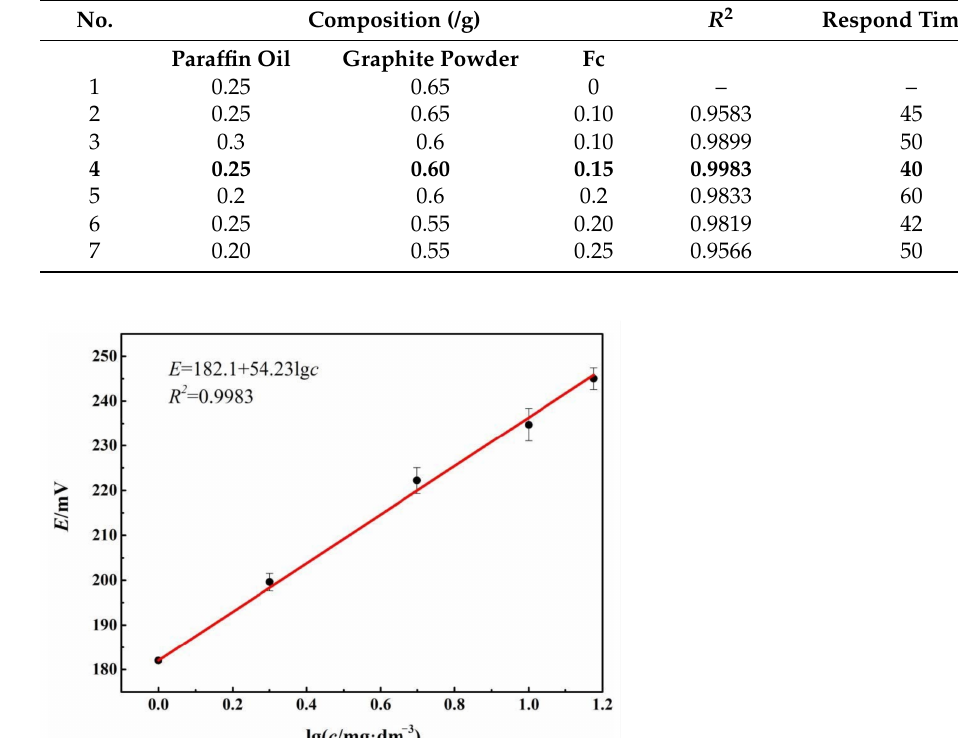
Table 1. The composition of the ferrocene (Fc)-modified carbon paste electrode.